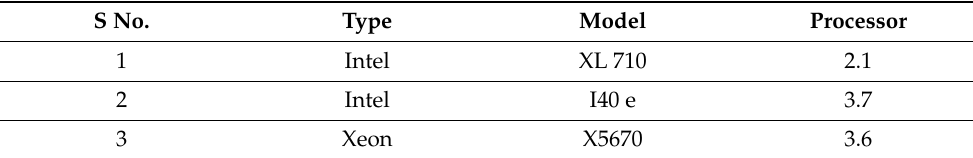
Table 2. Model description.